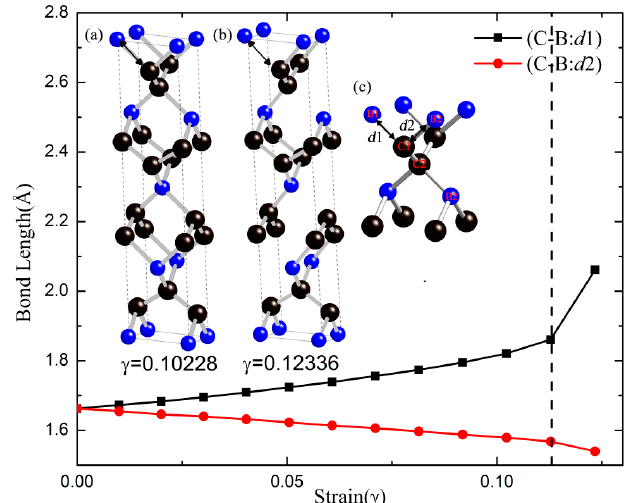
Figure 4. Calculated bond lengths as a function of strain for t- BC 2 under shear deformation along the (110)[001] directions. Insets: crystal structures before ( a ) and after ( b ) shear instability, and basic building blocks in t- BC 2 ( c ). The dashed line represents the shear-induced structural deformation’s first occurrence.